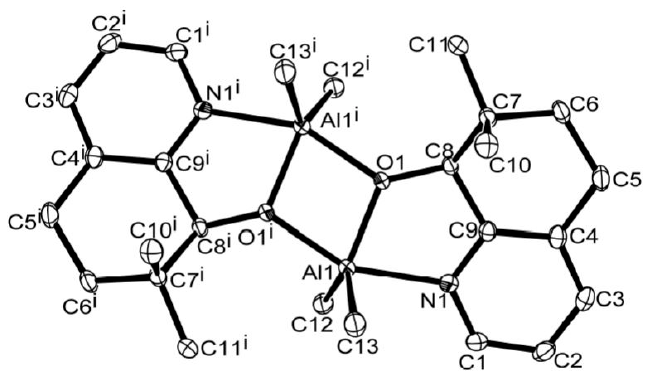
Figure 1. ORTEP representation of C1 . Thermal ellipsoids are shown at 30% probability while hydrogen atoms have been omitted for clarity.